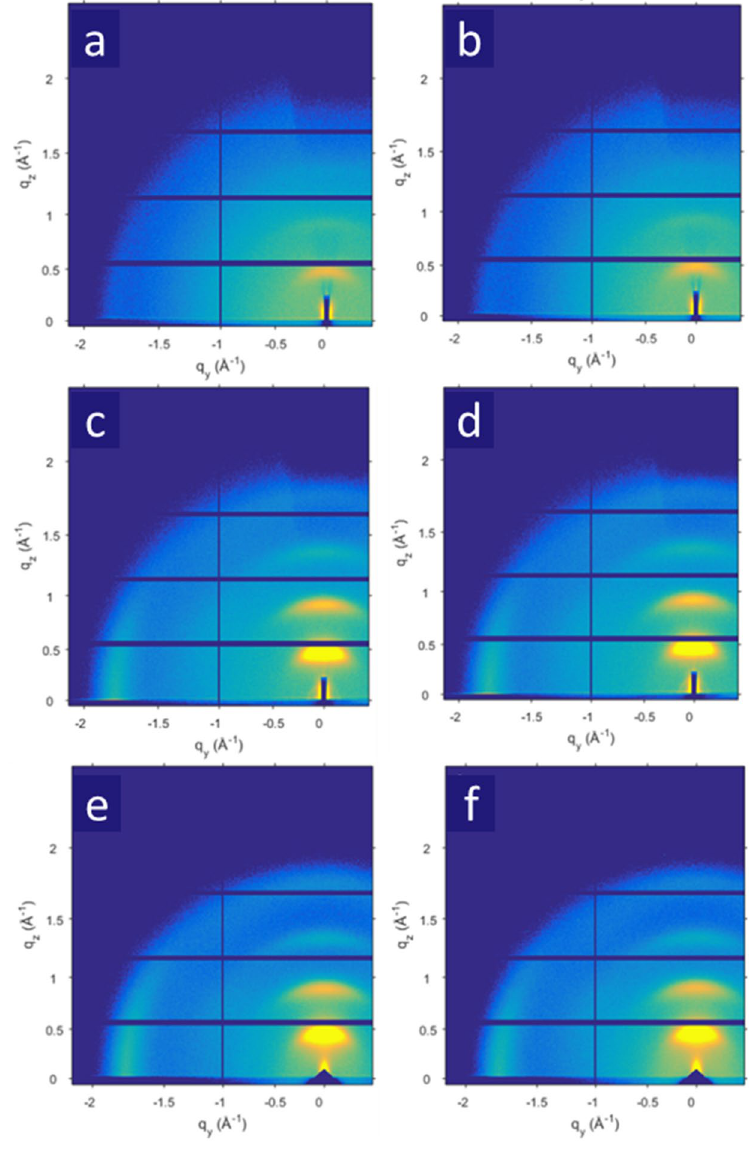
Figure 3. The GIWAXS patterns of the PEDOT:Tos thin films with different doping levels of Tos at ( a ) 23.7%; ( c ) 31.5%; and ( e ) 43.6% under no nitrogen flow pressure; and ( b ) 23.7%; ( d ) 31.5%; and ( f ) 43.6% under the nitrogen flow